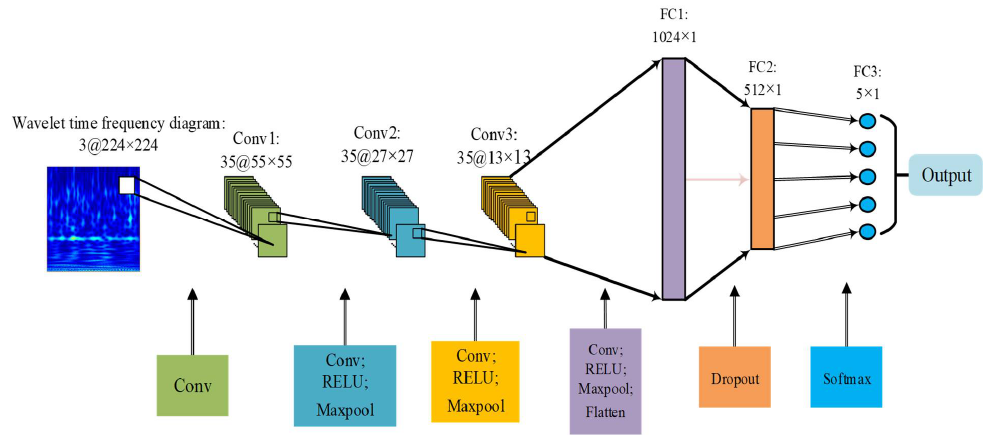
Figure 1. Improved AlexNet network model.